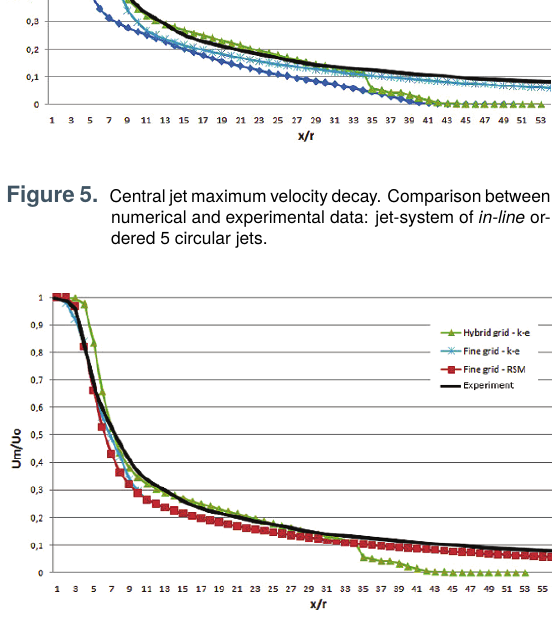
Figure 9. Velocity field through isosurfaces: 3x3 in-corridor jets with square shape, zoom section Z=0.